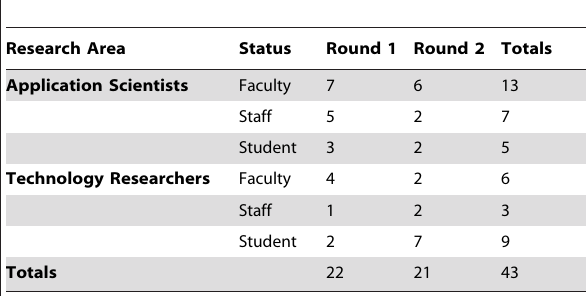
Table 1. Interview participants and their